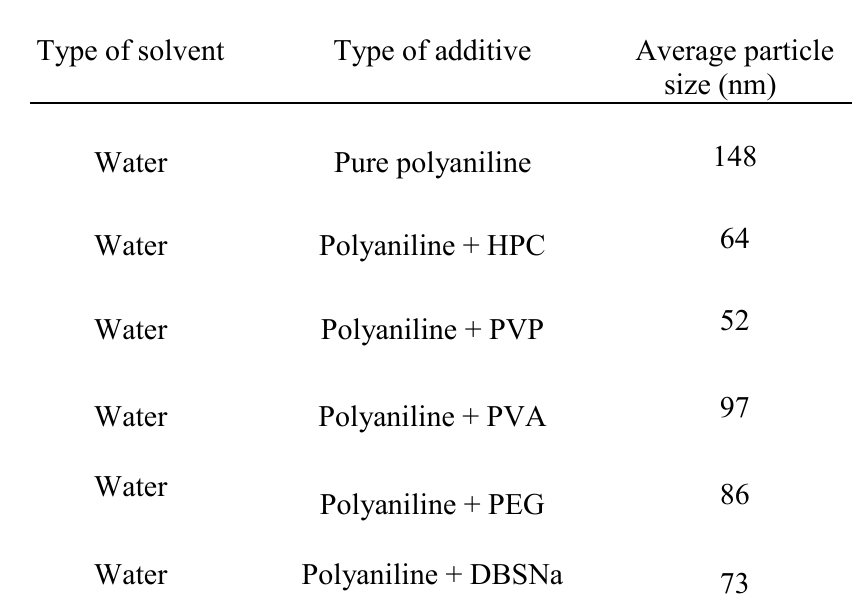
Table 1. Preparation conditions and some properties of